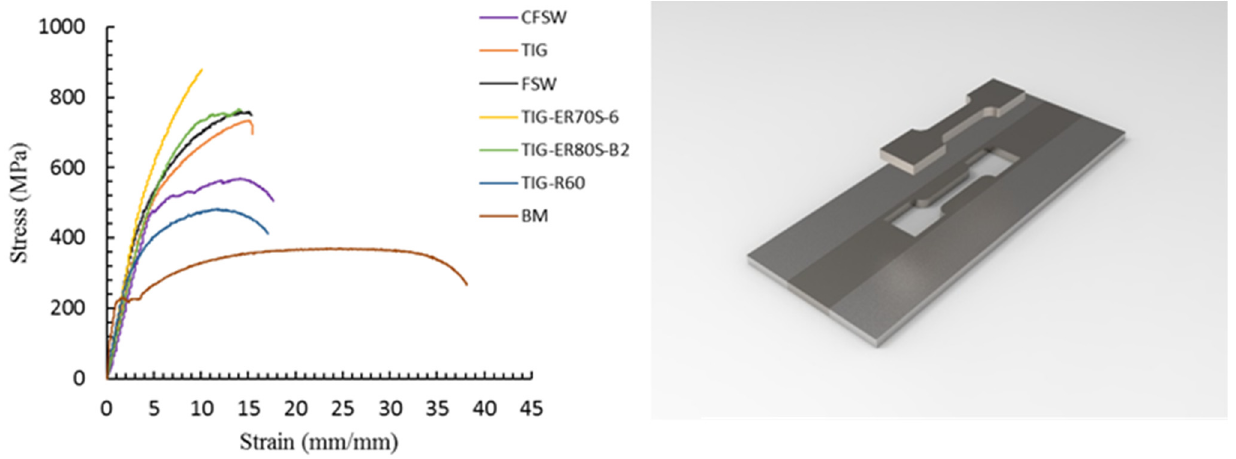
Figure 7. Tensile stress-strain curves of FSWed and TIG welded samples. Table 3. Mechanical properties of base metal (BM), FSWed and TIG welded samples. Yield Strength Sample